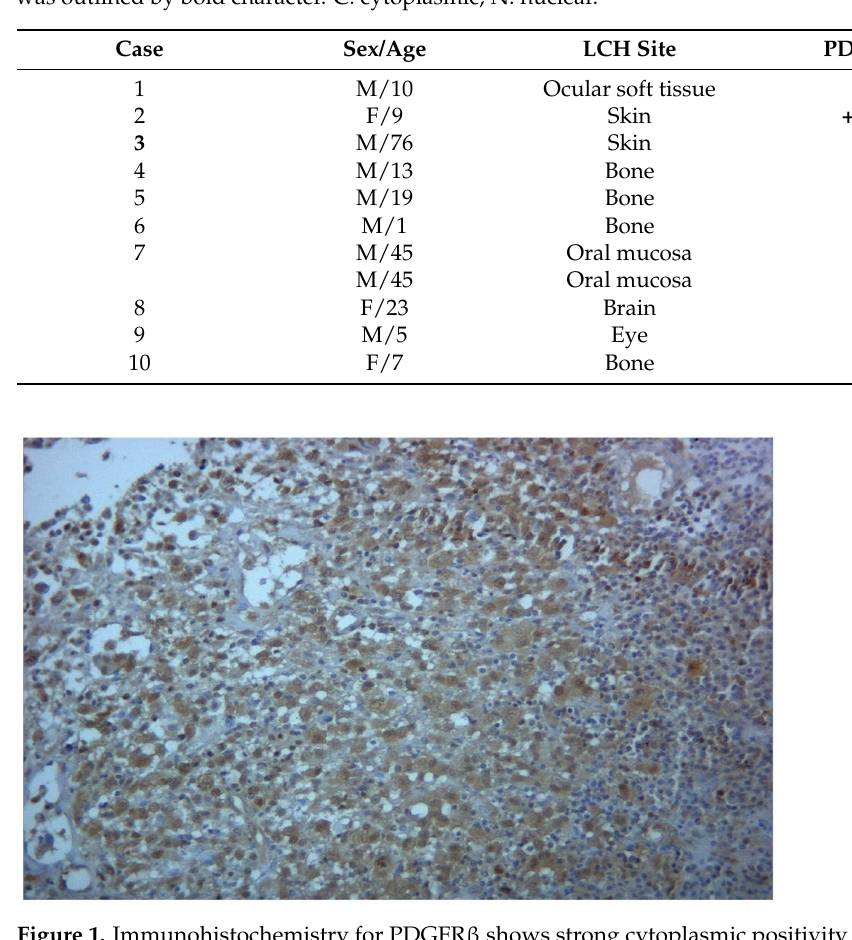
Figure 1. Immunohistochemistry for PDGFR β shows strong cytoplasmic positivity in Langerhans cells (magnification 106 ×